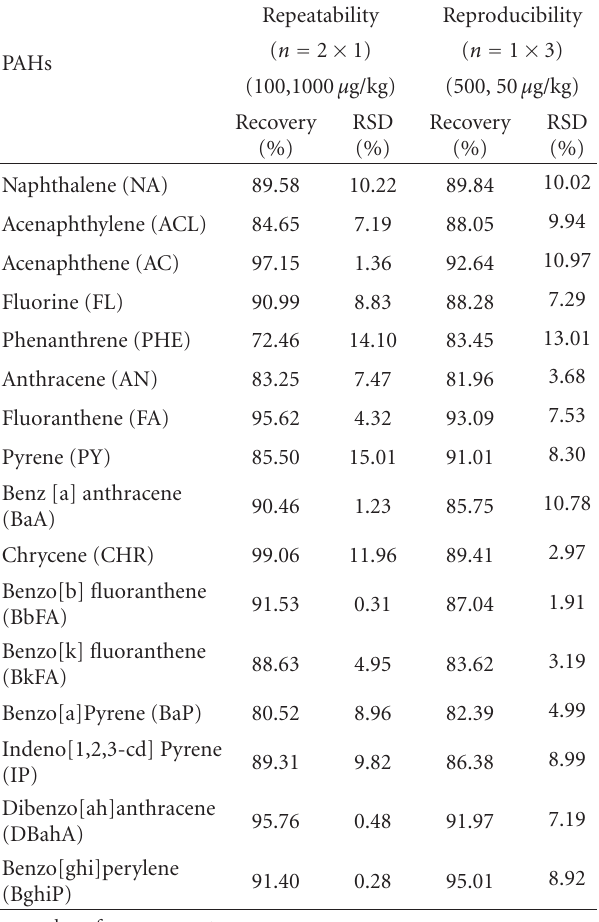
Table 4: Method and instrumental limit of detection (LOD) and limit of quantification (LOQ) of the 16